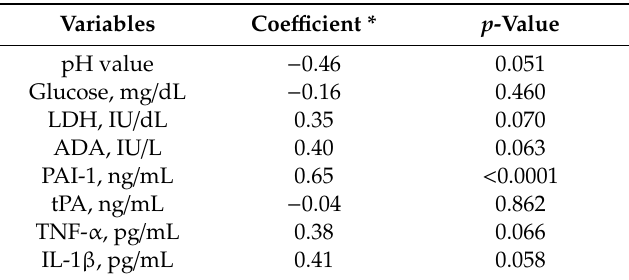
Table 2. Correlation between thrombin and inflammatory parameters, fibrinolytic factors and cytokines in TBPE ( n =